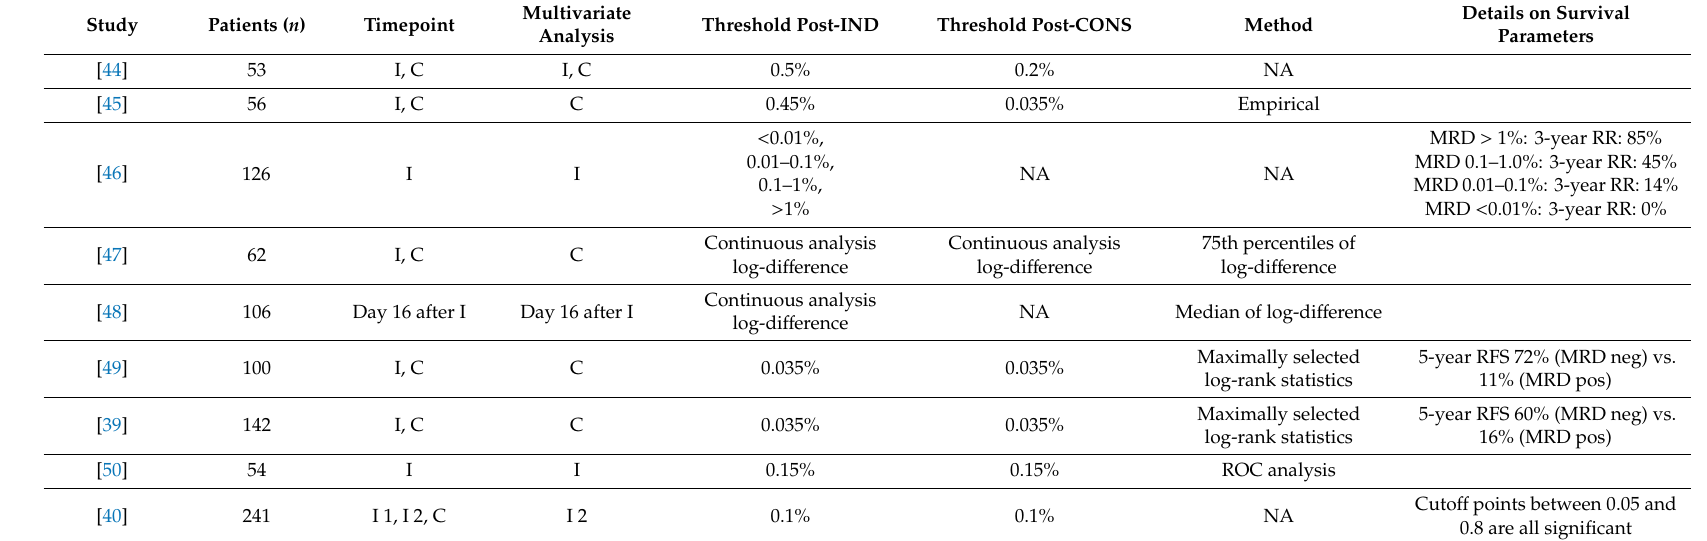
Table 2. Available studies on MRD detection by MFC provides strong prognostic information in AML after both induction and consolidation therapy.